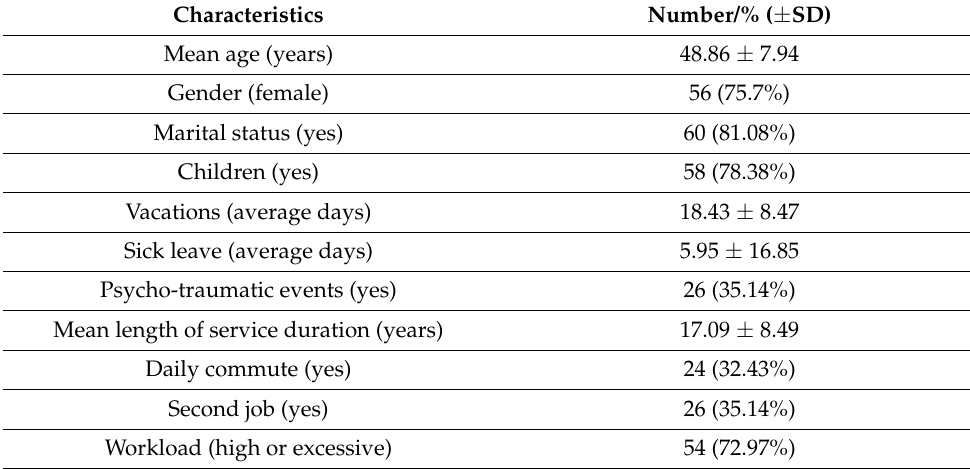
Table 1. Sociodemographic and professional characteristics of